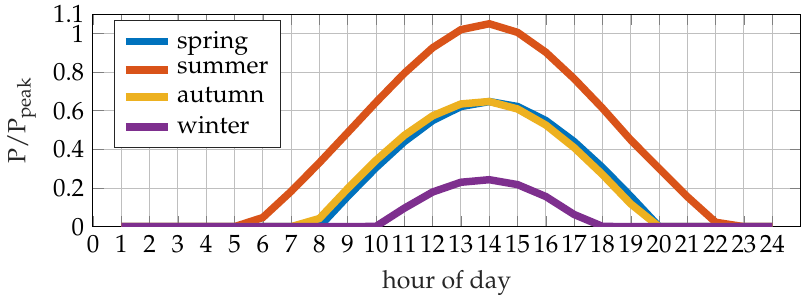
Figure 2. PV generation profile for the first day of Spring, Summer, Autumn and